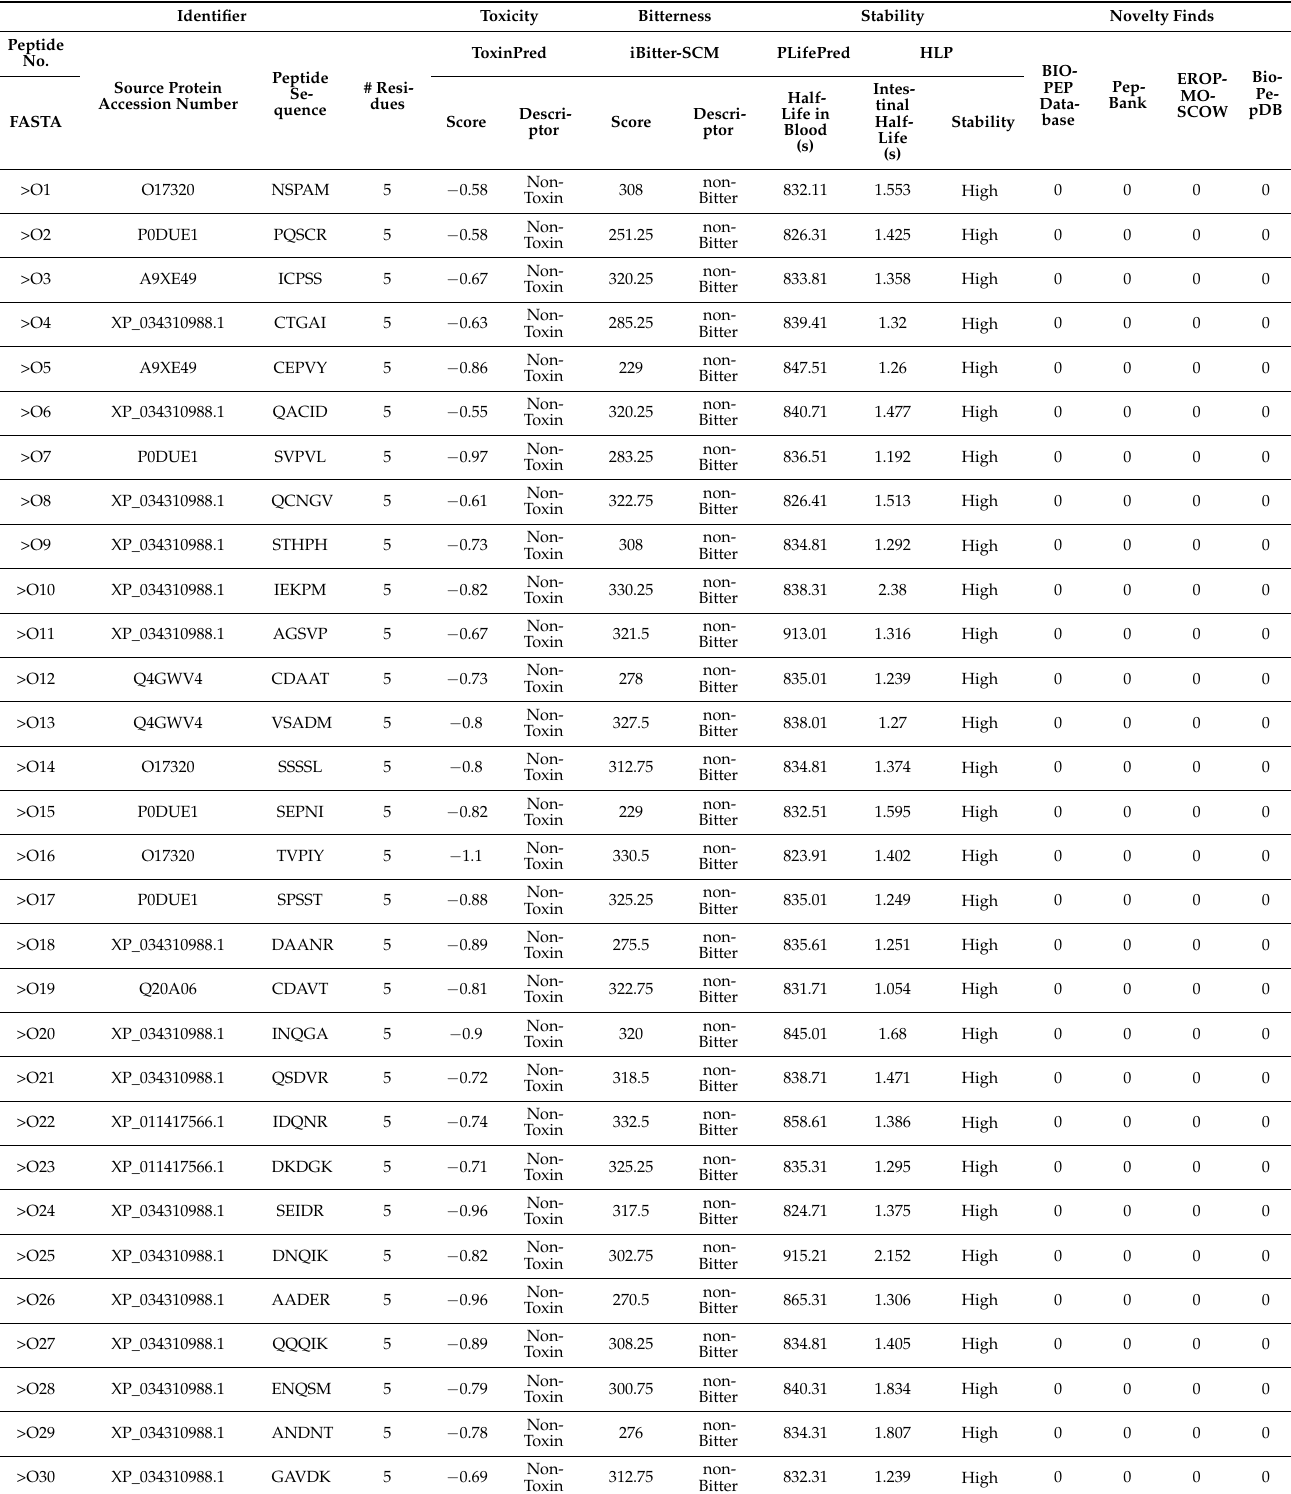
Table 2. Peptide candidate long list pre-screened for size range, toxicity, bitterness, stability, and